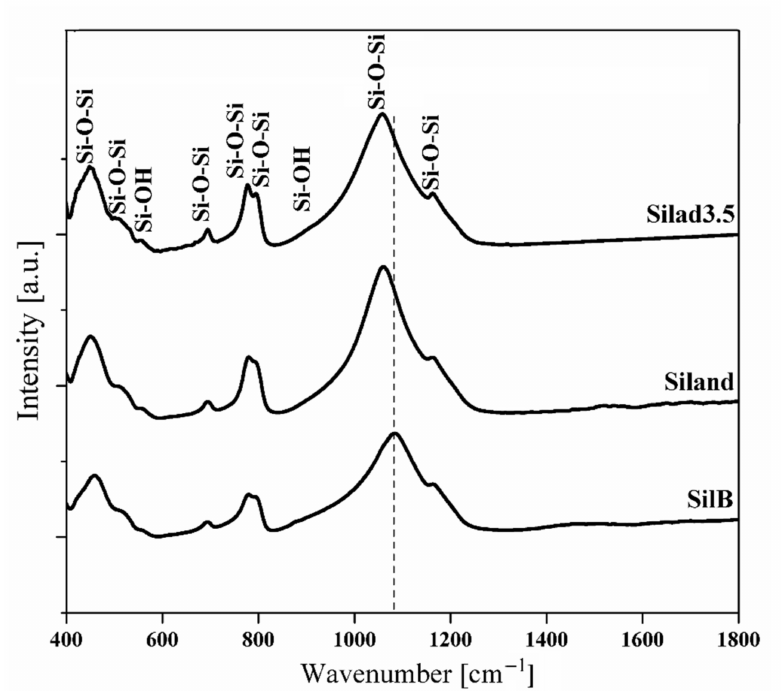
Figure 6. FTIR spectra of samples SilB, Siland, and Silad3.5.